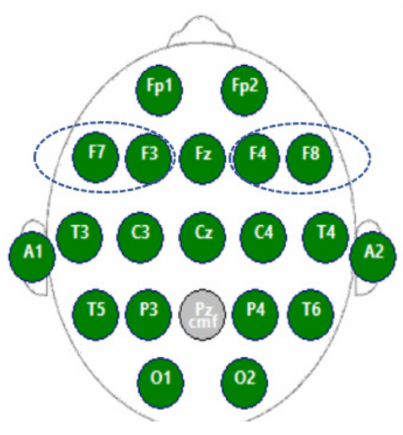
Figure 5. The positions of the electrodes of the EEG